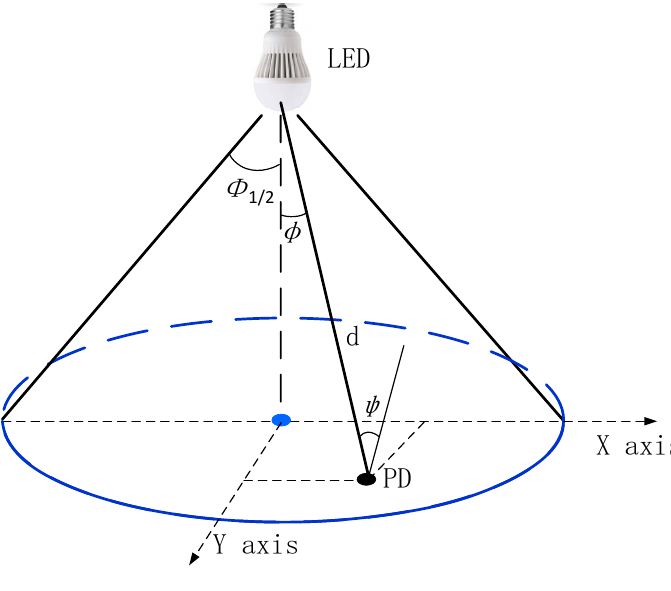
Figure 1. Optical channel